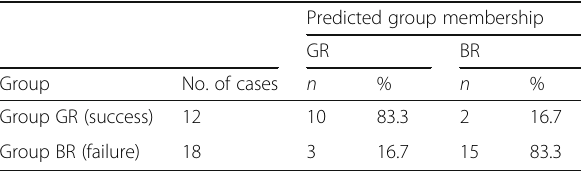
Table 4 Discriminant analysis